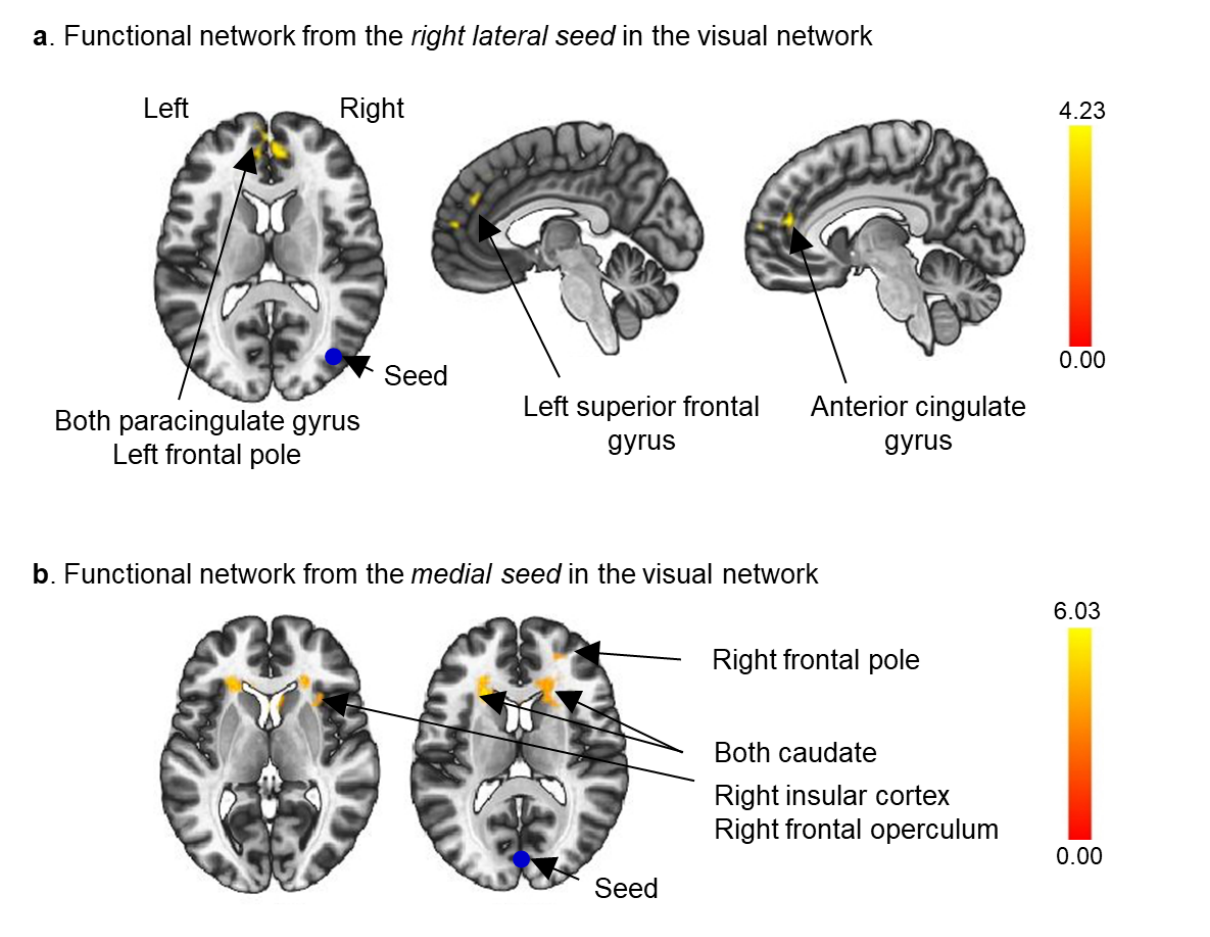
Figure 2. Seed-to-voxel analyses based on the right lateral region (a) and the medial region (b) of the visual network (blue circles). Increased frontal-occipital functional connectivity related to the Rey-Osterrieth Complex Figure Test copy task improvement after virtual reality cognitive training. False discovery rate–corrected P <.05 for cluster threshold; uncorrected P <.001 for voxel